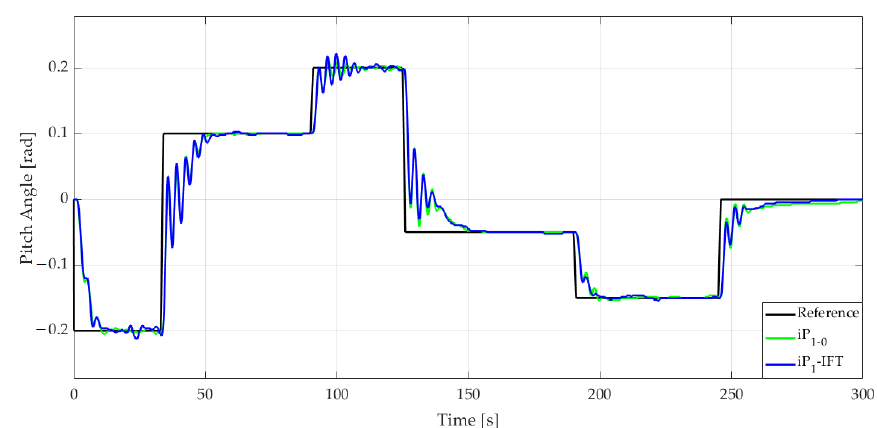
Figure 6. Comparison between iP 1-0 and iP 1 -IFT controllers for the pitch angle variation experiments.